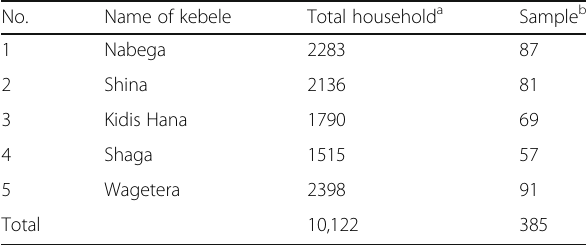
Central Statistical Agency 2007 a The data was taken from Ethiopian Central Statistics Agency (CSA) b The data was found from sample respondents using the formula of Kothari